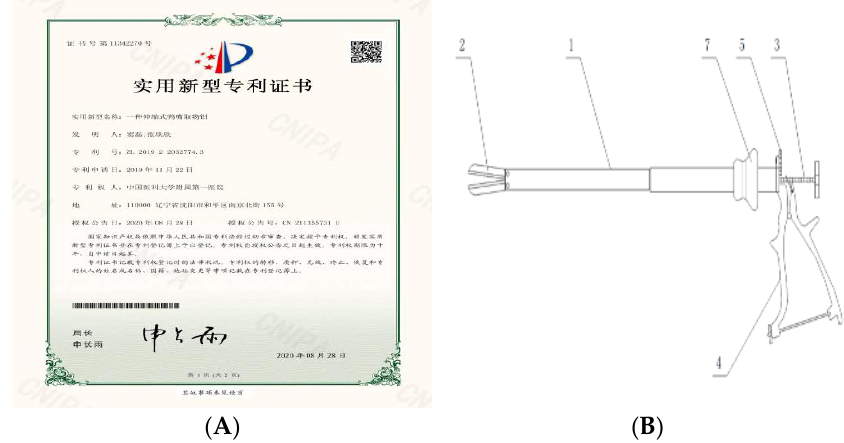
Figure 6. ( A ) The patent for the fibroid extraction forceps. ( B ) The schematic diagram of myoma forceps used for endoscopy. In the picture: 1- telescopic tube, 2- duckbill clamp, 3- pulling device, 4- pressing handle, 5- adjusting gear, 7- rubber locking ring.